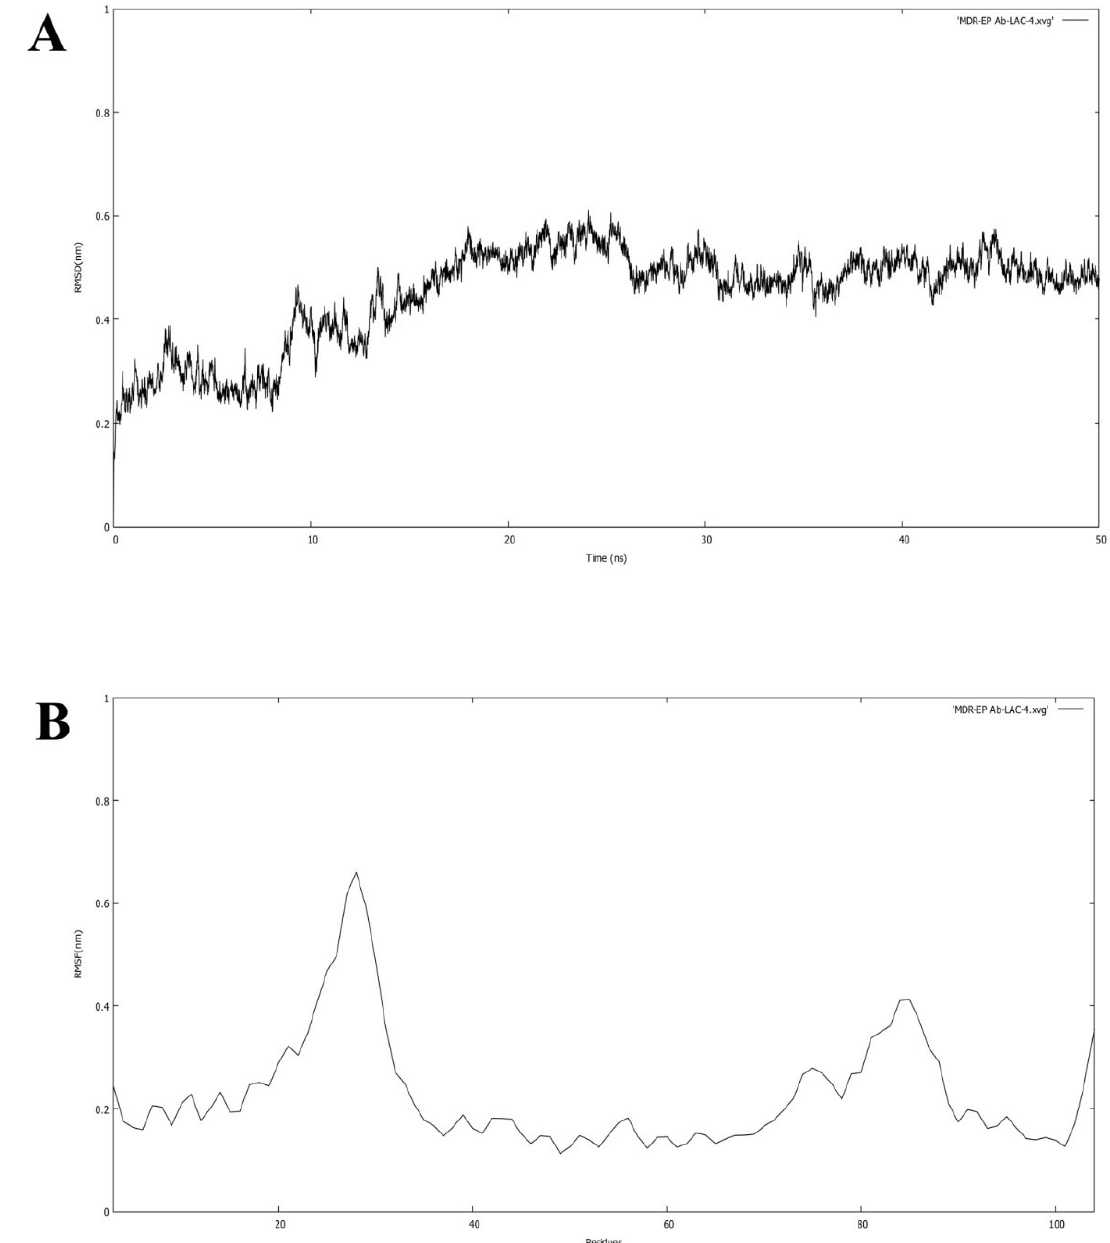
Figure 6. ( A ) RMSD of the backbone of efflux protein forms during the simulation run of 50 ns. ( B ) RMSF of the protein for each residue of the efflux protein.